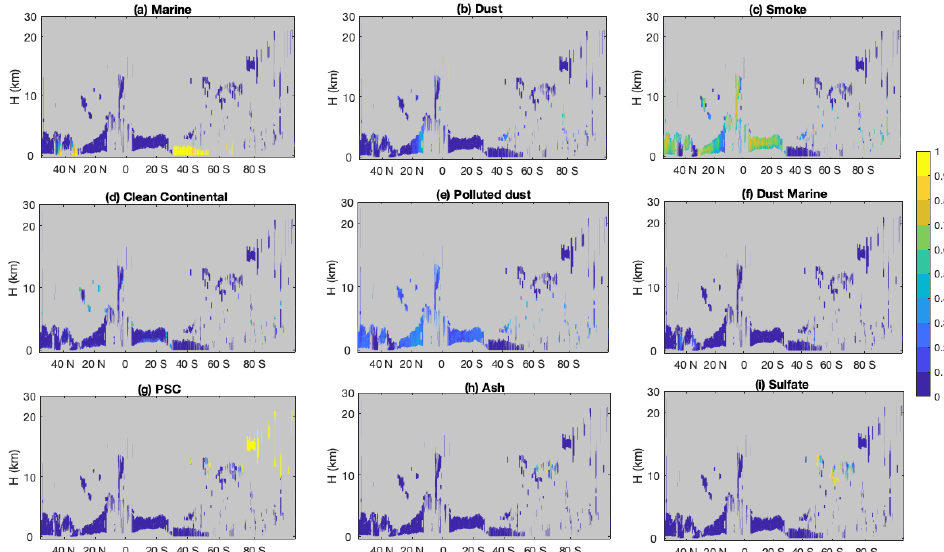
Figure 6. CNN classification scores assigned to all aerosol classes ( a ): marine aerosols; ( b ): dust; ( c ): smoke; ( d ): clean continental; ( e ): polluted dust; ( f ): dust marine aerosols; ( g ): PSC aerosols; h ): ash; ( i ): sulfate or other stratospheric aerosols) for nighttime data acquired on 19 June 2011, starting at 23:53:12 UTC shown in Figure 5.